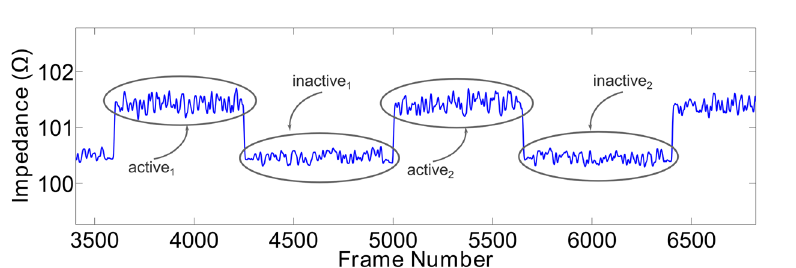
Figure 3. Cohen’s d effect size of volume difference over the 150 minutes seated period. Effect size is computed as the mean difference divided by the standard deviation of differences. Overall, effect size rises throughout the entire period seated, with a distinct peak at 20 minutes driven by the sharp rise in the difference in leg fluid accumulation and low variability.